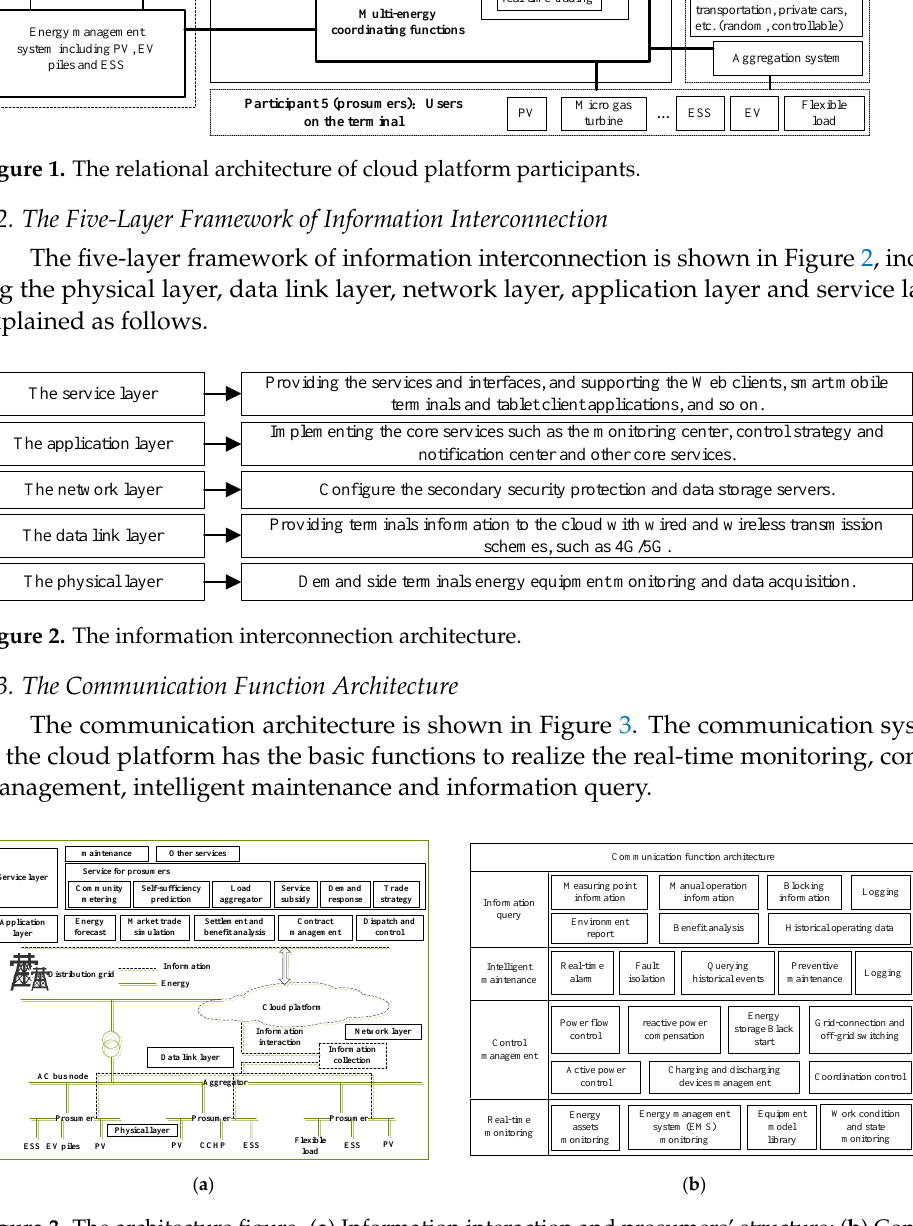
Figure 3. The architecture figure. ( a ) Information interaction and prosumers’ structure; ( b ) Commu- nication function architecture.